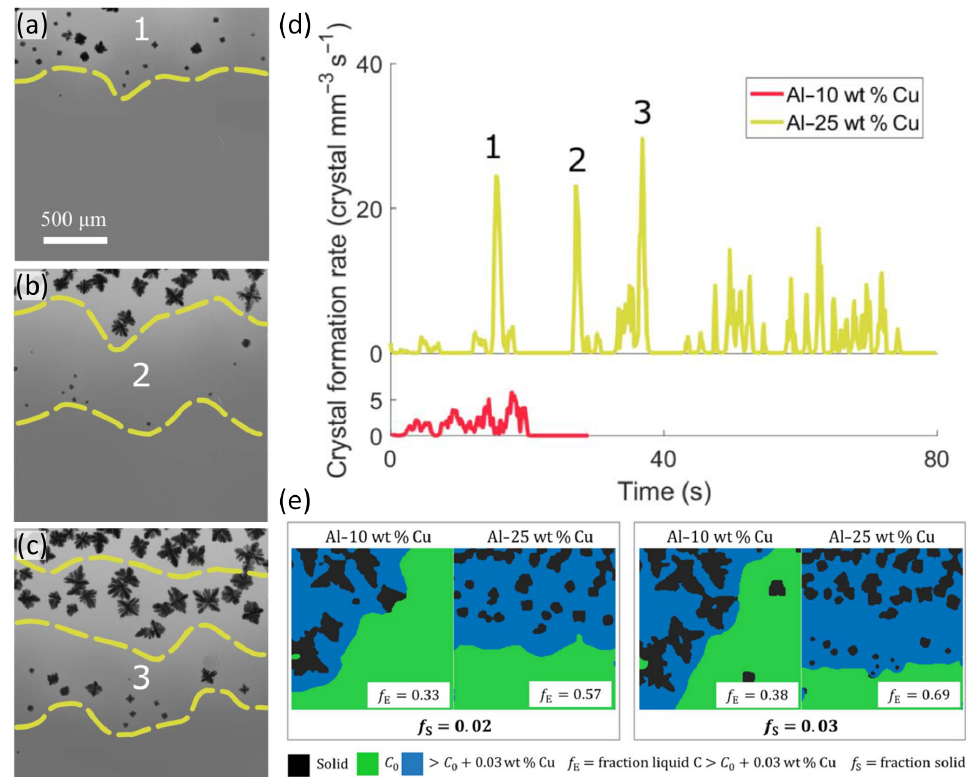
Figure 3. ( a – c ) A radiograph sequence showing the solidification of a TiB 2 inoculated Al-25wt.%Cu al- loy at a constant cooling rate of 0.3Ks − 1 . Image frames time t = 16, 29, and 38 s showing, respectively, three successive formation waves (time t = 0 s was set when a crystal first appeared). ( d ) Crystal formation rate as a function of time for the experiment shown in ( a – c ) (yellow curve), showing more pronounced formation bursts than the Al-10wt.%Cu counterpart (red curve). ( e ) Fraction of the Cu-rich liquid ( f E , coloured in blue) at fraction solid f S of 0.02 and 0.03 during the solidification of Al-10wt.%Cu and Al-25wt.%Cu